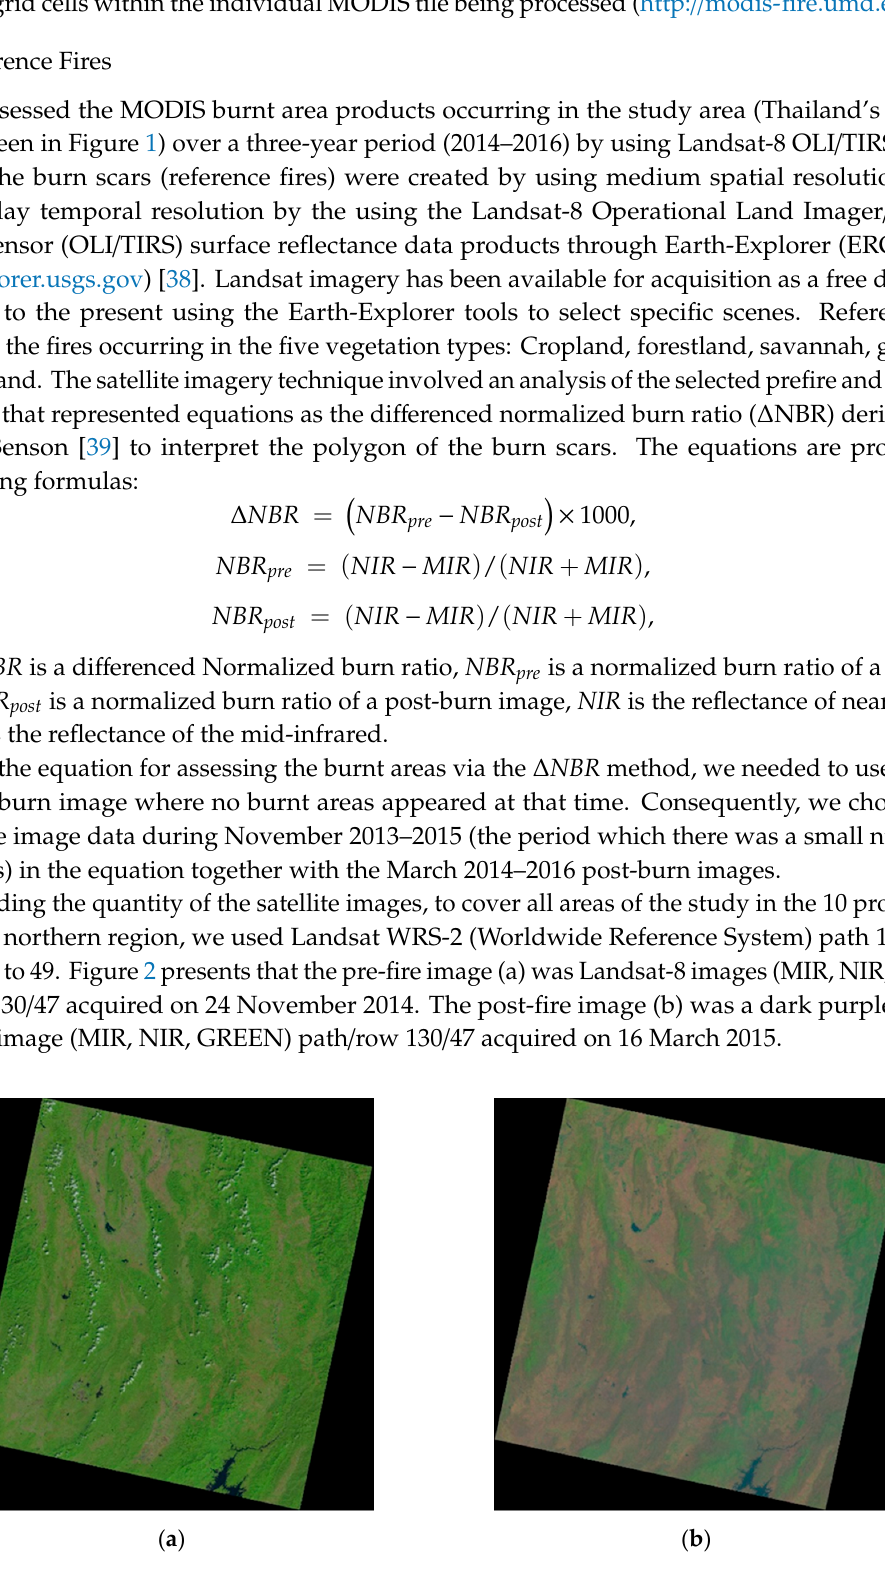
Figure 2. The pre-fire image ( a ) derived from Landsat 8 image (MIR, NIR, GREEN) path/row 130/47 acquired on 24 November 2014. The post-fire image ( b ) is a dark purple color Landsat 8 image (MIR, NIR, GREEN) path/row 130/47 acquired on 16 March, 2015.